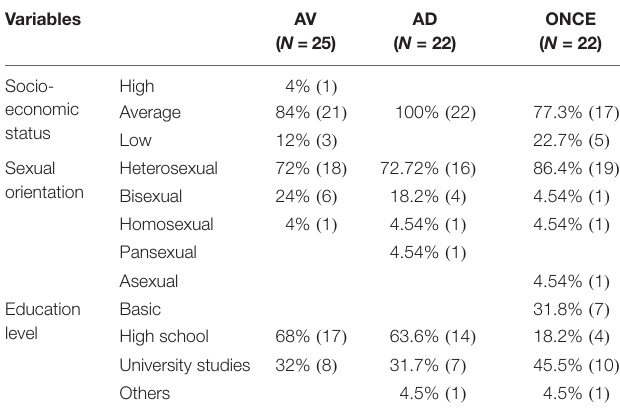
TABLE 1 | General sample